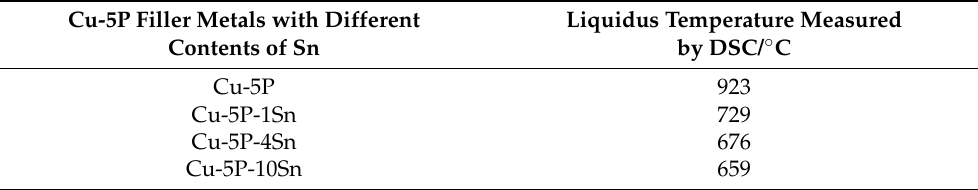
Table 4. Melting temperatures of Cu-5P filler metals with different contents of Sn [45].